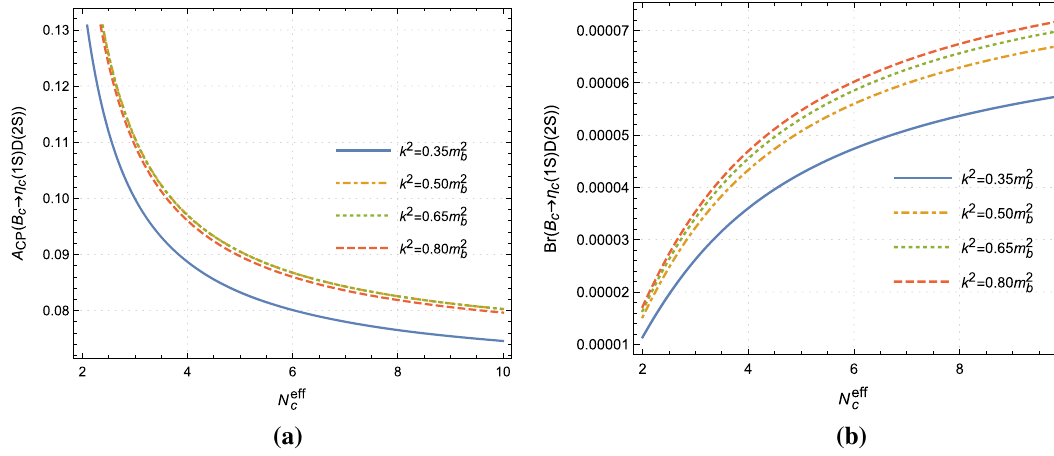
Fig. 6 A cp and averaged branching ratio of B c → η c ( 1 S ) D ( 2 S ) change with k 2 and N ef f c